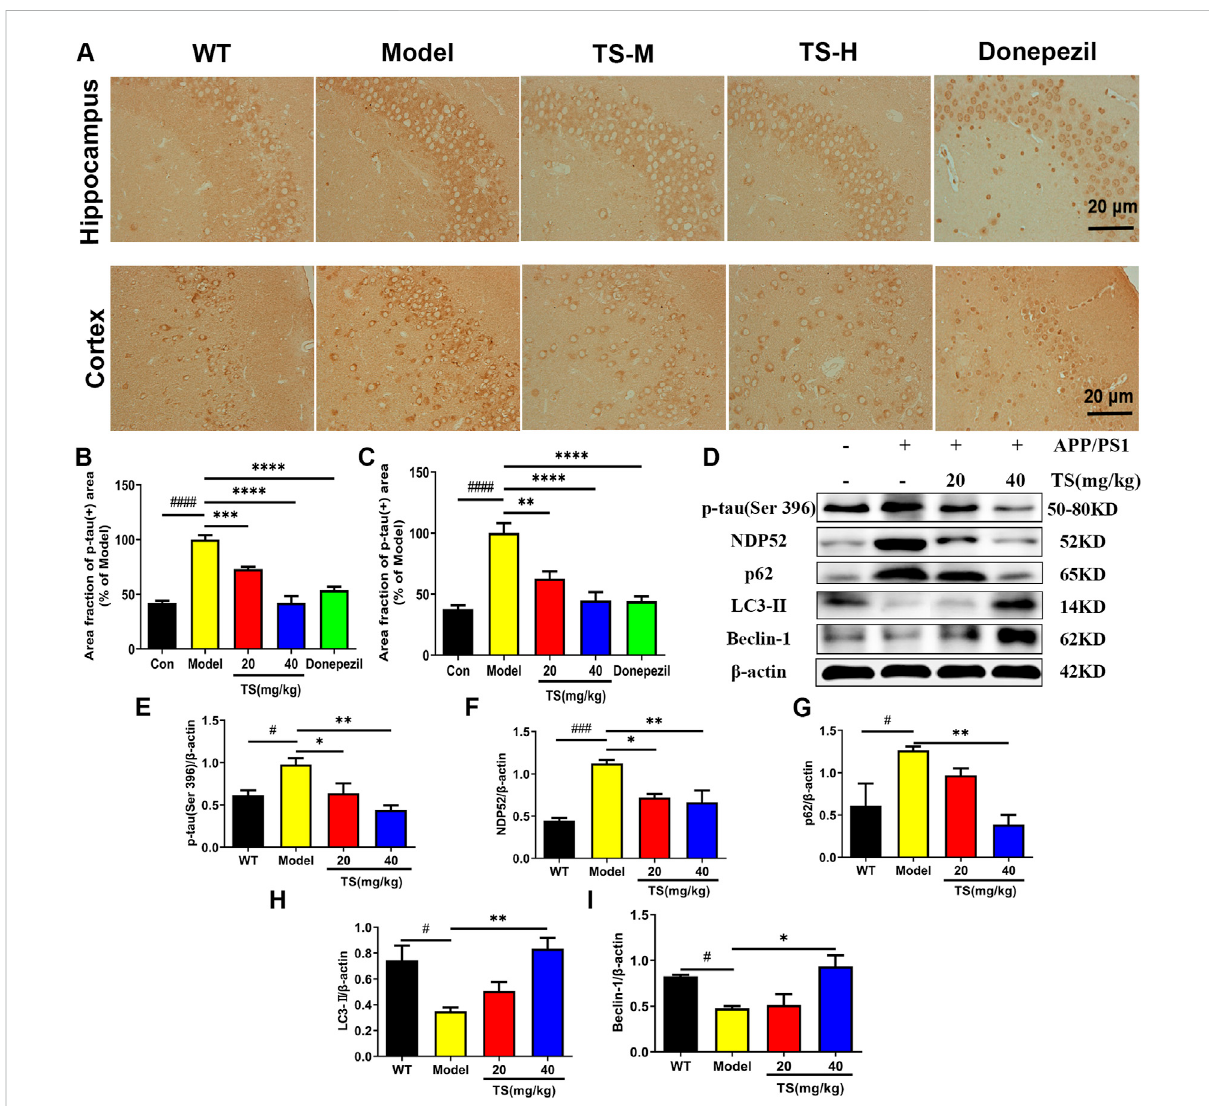
FIGURE 5 Effects of TS on expressions of p- tau, NDP52, p62 and LC3-II proteins in APP/PS1 mice. (A) The effect of TS on p- tau (ser396) in hippocampus andcortexofAPP/PS1 micewasinvestigatedbyimmunohistochemistry. (B) Quantitativeanalysisofthepercentageof p- tau(Ser396)positiveareain the hippocampus of APP/PS1 mice ( #### p < 0.0001, *** p = 0.0007, **** p < 0.0001). (C) Quantitative analysis of the percentage of p- tau (Ser396) positive area in the cortex of APP/PS1 mice ( #### p < 0.0001, ** p = 0.0016, **** p < 0.0001). (D) The effects of TS on expressions of p- tau (Ser 396),NDP52,p62andLC3-IIproteins inthebrainofAPP/PS1 miceweredetected byWesternblot. (E) Quantitative analysis oftherelativeexpression level of p- tau (Ser 396) protein in each group ( # p = 0.0332, * p = 0.0436, ** p = 0.0042). (F) Quantitative analysis of the relative expression level of NDP52 protein in each group ( ### p = 0.0008, * p = 0.0177, ** p = 0.0086). (G) Quantitative analysis of the relative expression level of p62 protein in each group ( # p = 0.0379, ** p = 0.0086). (H) Quantitative analysis of the relative expression level of LC3-II protein in each group ( # p = 0.0216, ** p